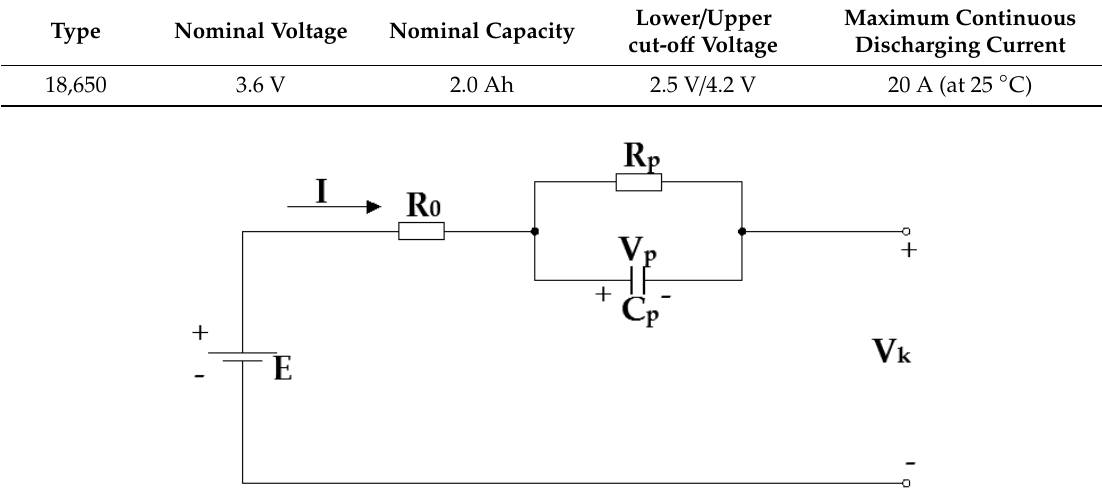
Figure 1. Resistor and capacitance equivalent circuit model.